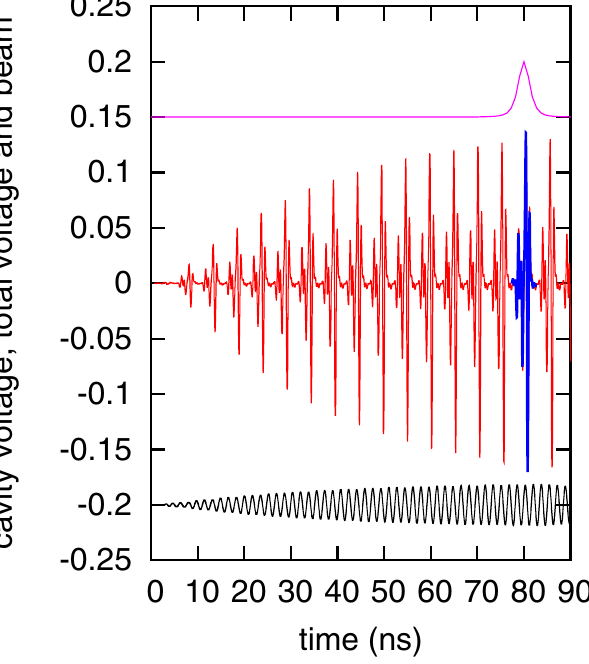
FIG. 3. (Color) Scheme for creating the kicker pulse. The top trace is the bunch current. The desired voltage is the blue trace on the center curve. The beam is present only where this trace is nonzero. The red curve is the total kicker voltage and the black curve below is the voltage on one of the cavities.